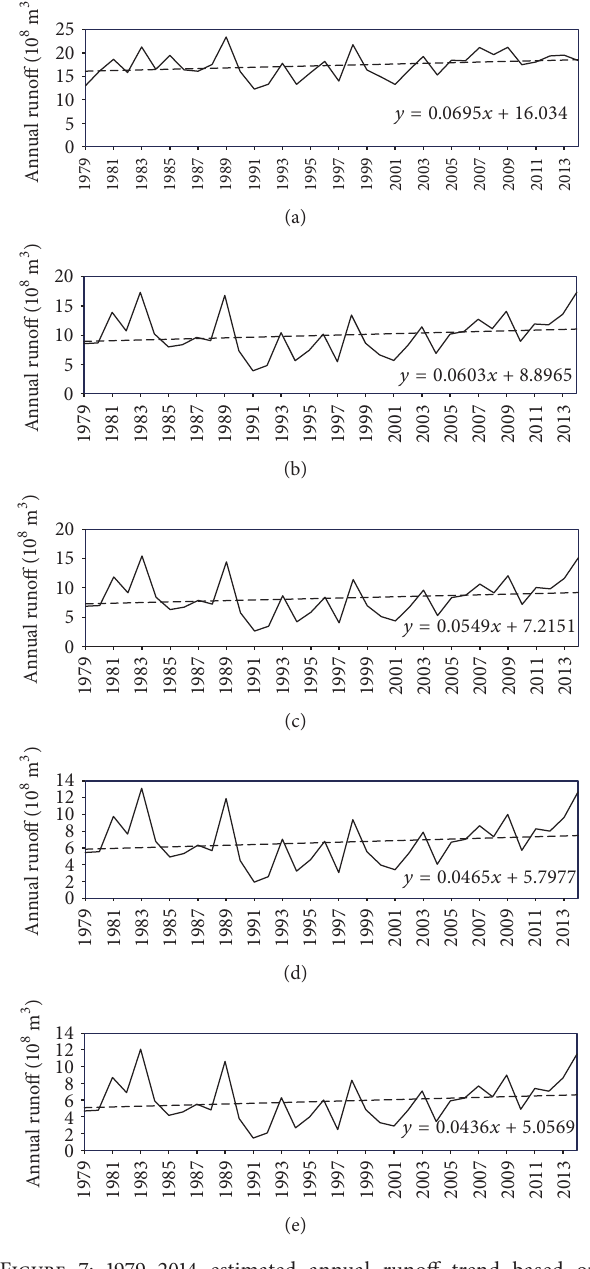
Figure 7: 1979–2014 estimated annual runoff trend based on regressionanalysesattheYingluoxia(a),Caotanzhuang(b),theS213 Bridge (c), the G312 Bridge, (d) and the Tielu Bridge